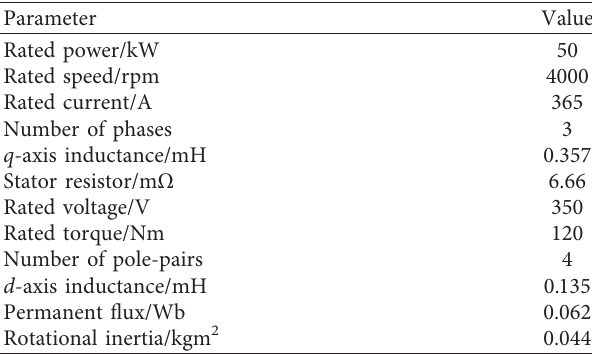
Table 9: Values of the parameters of